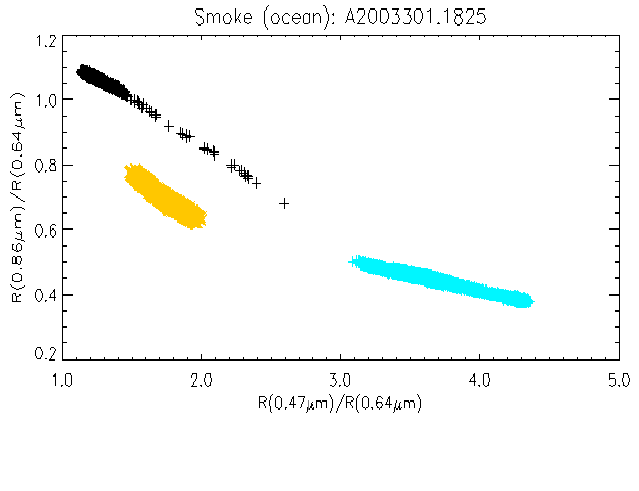
Figure 12. Scatter plot of R pixels (blue), smoke pixels (yellow), and cloudy pixels (black) for the case of Figure